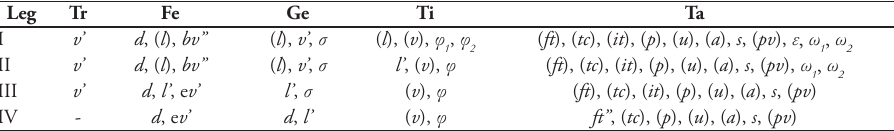
Table 2. Leg setation and solenidia of adult Eurostocepheus (Eurostocepheus) aquilinus Aoki, 1965. Leg Tr Fe